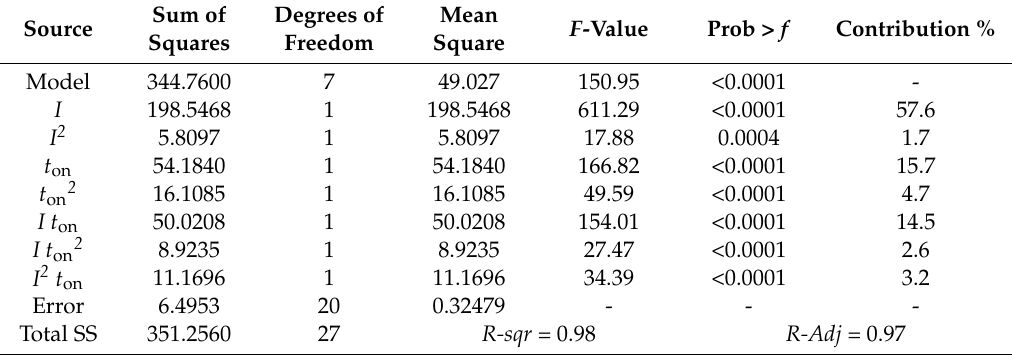
Table 6. The analysis of variance (ANOVA) table for the Sa ( after elimination).